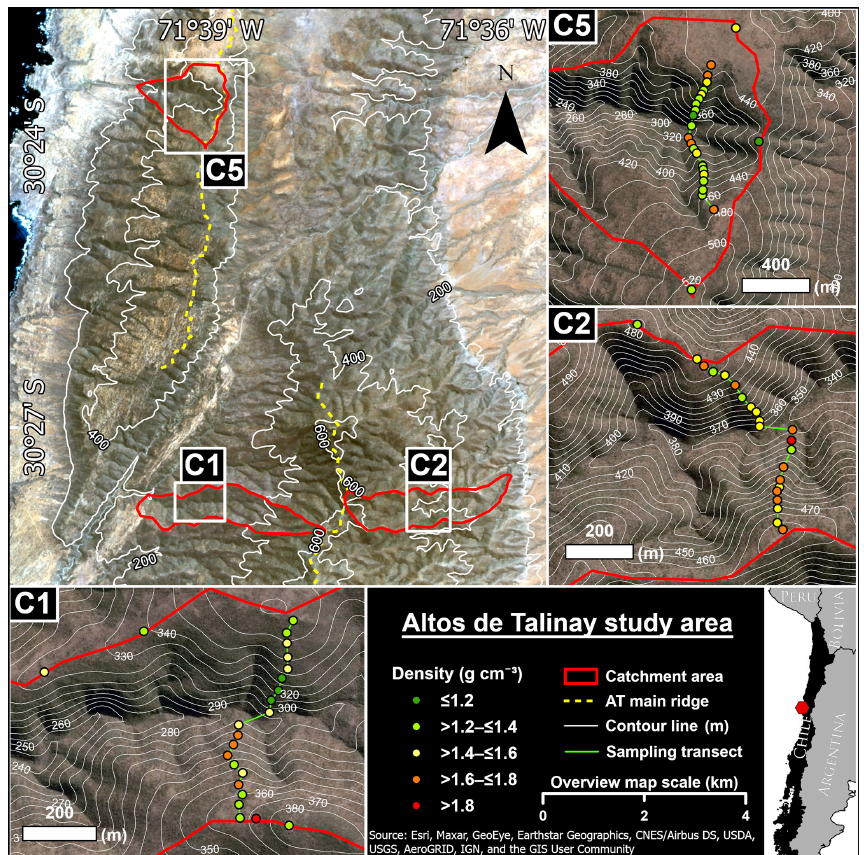
Figure 9. Sentinel 2B satellite image showing the location of the AT17–18 study area (overview map). Zoomed inlets show sampling transects and field-state soil bulk densities calculated from SfM-MVS photogrammetry-based volume derivations and in-field excavation mass weighting (satellite image source: ArcGIS World